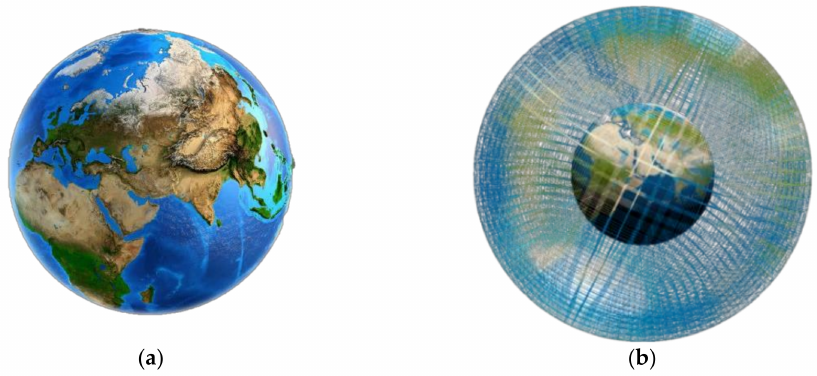
Figure 1. From the planet Earth to digital discrete Earth: ( a ) planet Earth; ( b ) digital discrete